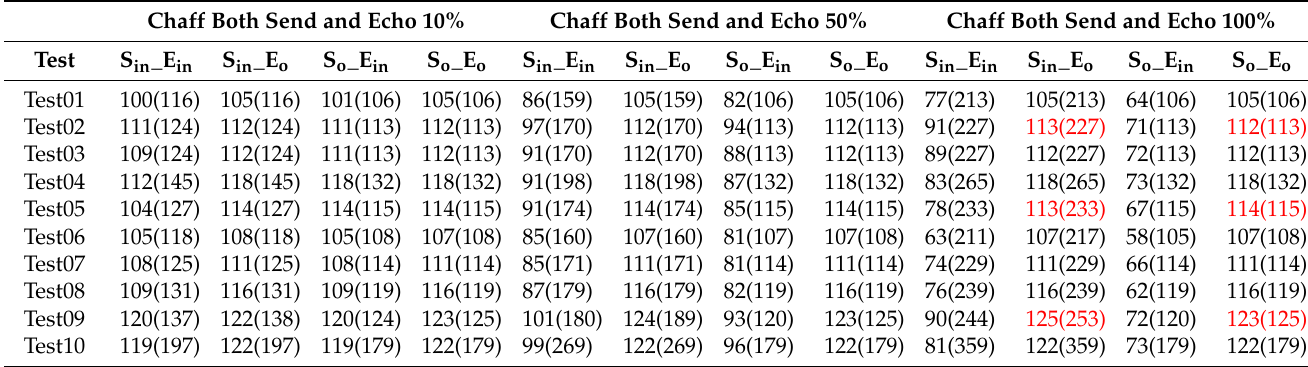
Table 5. Packet cross-matching results with both Send and Echo chaffed rate 10%, 50%, and 100% at